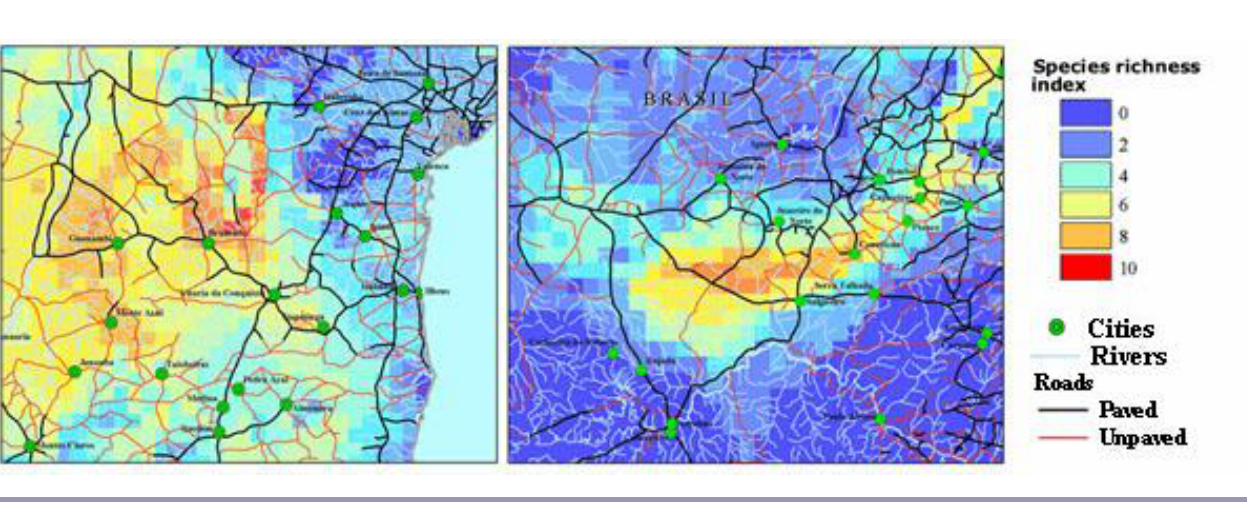
Fig. 6 . Details of selected Brazilian areas.